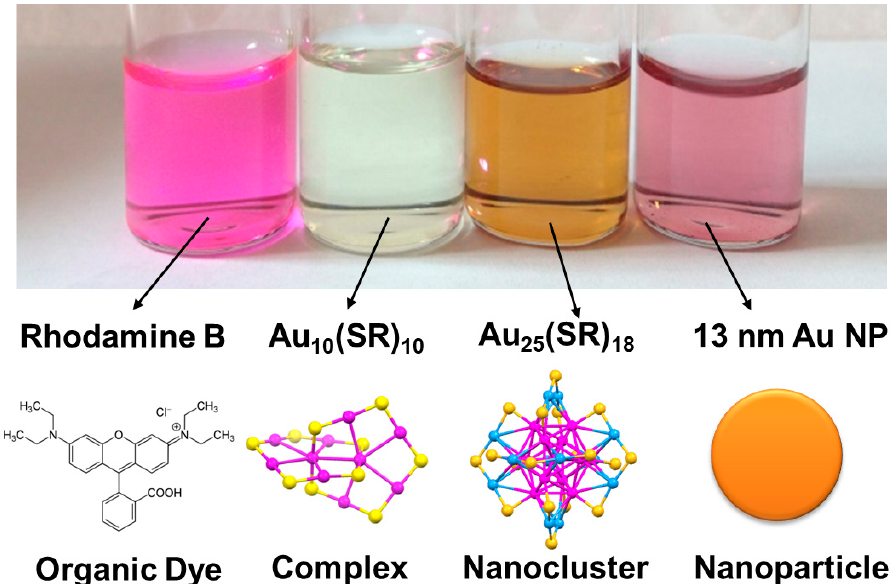
Figure 1. (Upper panel) Photograph of dilute solutions of Rhodamine B, sub-nanometer Au 10 (SR) 10 complex, 1 nm Au 25 (SR) 18 nanocluster, and ~13 nm diameter gold nanoparticles. (Lower